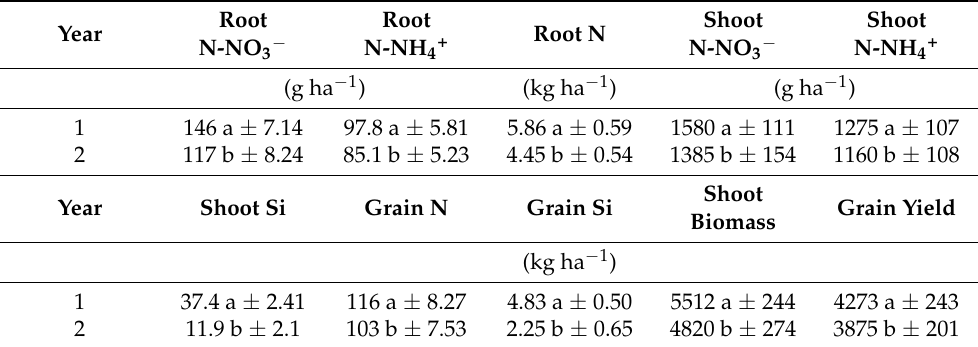
Table 6. Wheat root nitrate (N-NO 3 − ); root ammonium (N-NH 4+ ); root N accumulation; shoot N-NO 3 − ; shoot N-NH 4+ ; shoot Si accumulation; grain N; grain Si accumulation; shoot biomass and grain yield as a function of years of